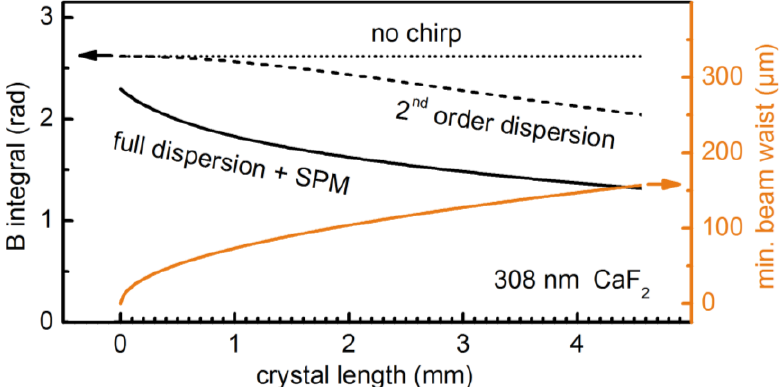
Figure 1. Amount of self-phase modulation (SPM) for 25 fs, 308 nm, 3 μJ UV pulses broadened in a CaF crystal. Calculated B-integral at increasing levels of theory for varied 2 crystal length. The input beam waist is set to a value for which the self-focal length